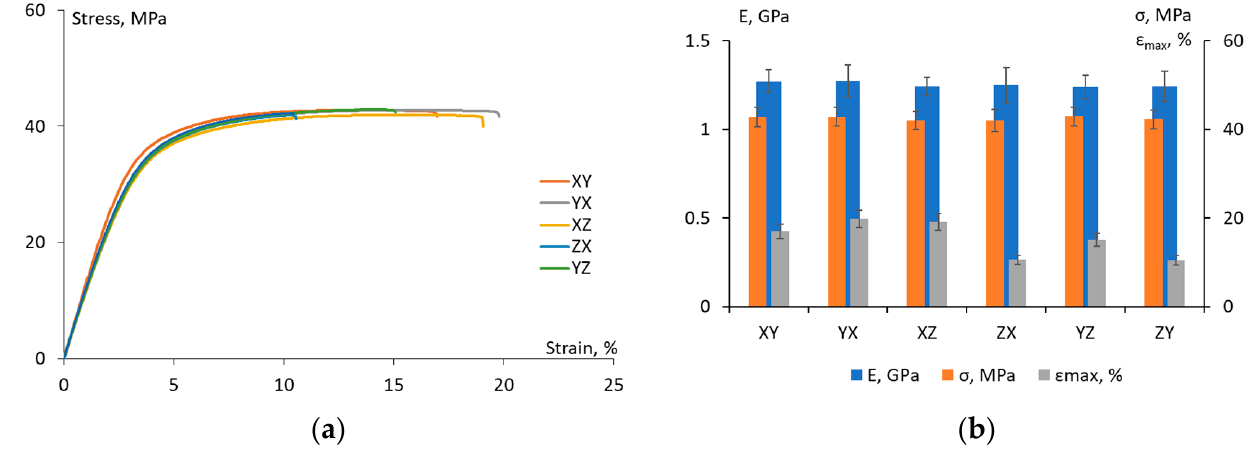
Figure 5. Representative stress-strain curves ( a ) and tensile characteristics ( b ) for the samples printed in different directions, as indicated on the graph.